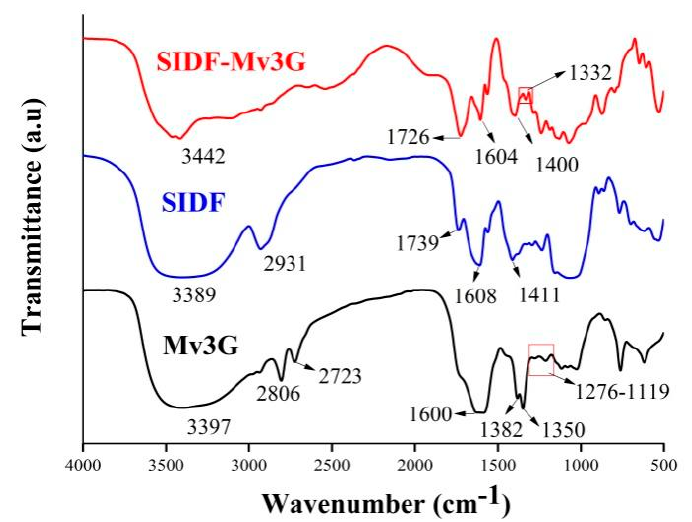
Figure 5. Fourier transform infrared spectra. SIDF-Mv3G: the stability system of soybean insoluble dietary fiber and malvidin-3- O -glucoside; Mv3G: malvidin-3- O -glucoside; SIDF: soybean insoluble dietary fiber.